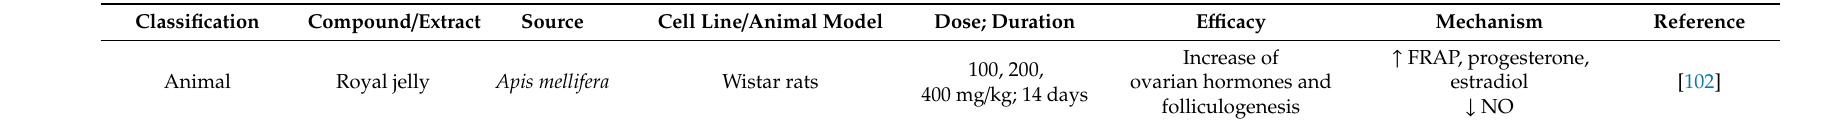
Table 9. Animal derived natural products and female